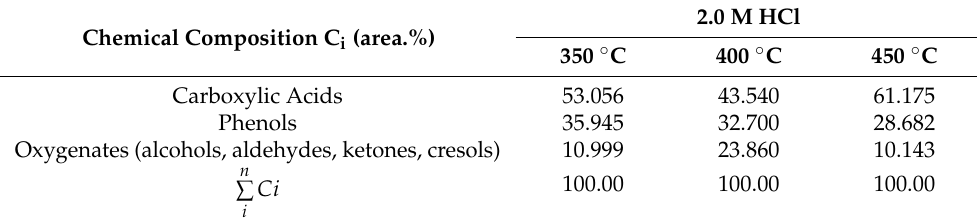
Table 7. Chemical composition of major compounds (carboxylic acids, phenols) and oxygenates (alcohols, ketones, aldehydes, etc.) of bio-oil obtained by pyrolysis of Aça í seeds, activated with 2.0 M HCl solution, at 350, 400, and 450 ◦ C, 1.0 atmosphere, in laboratory scale, identified by GC-MS. Chemical Composition C i